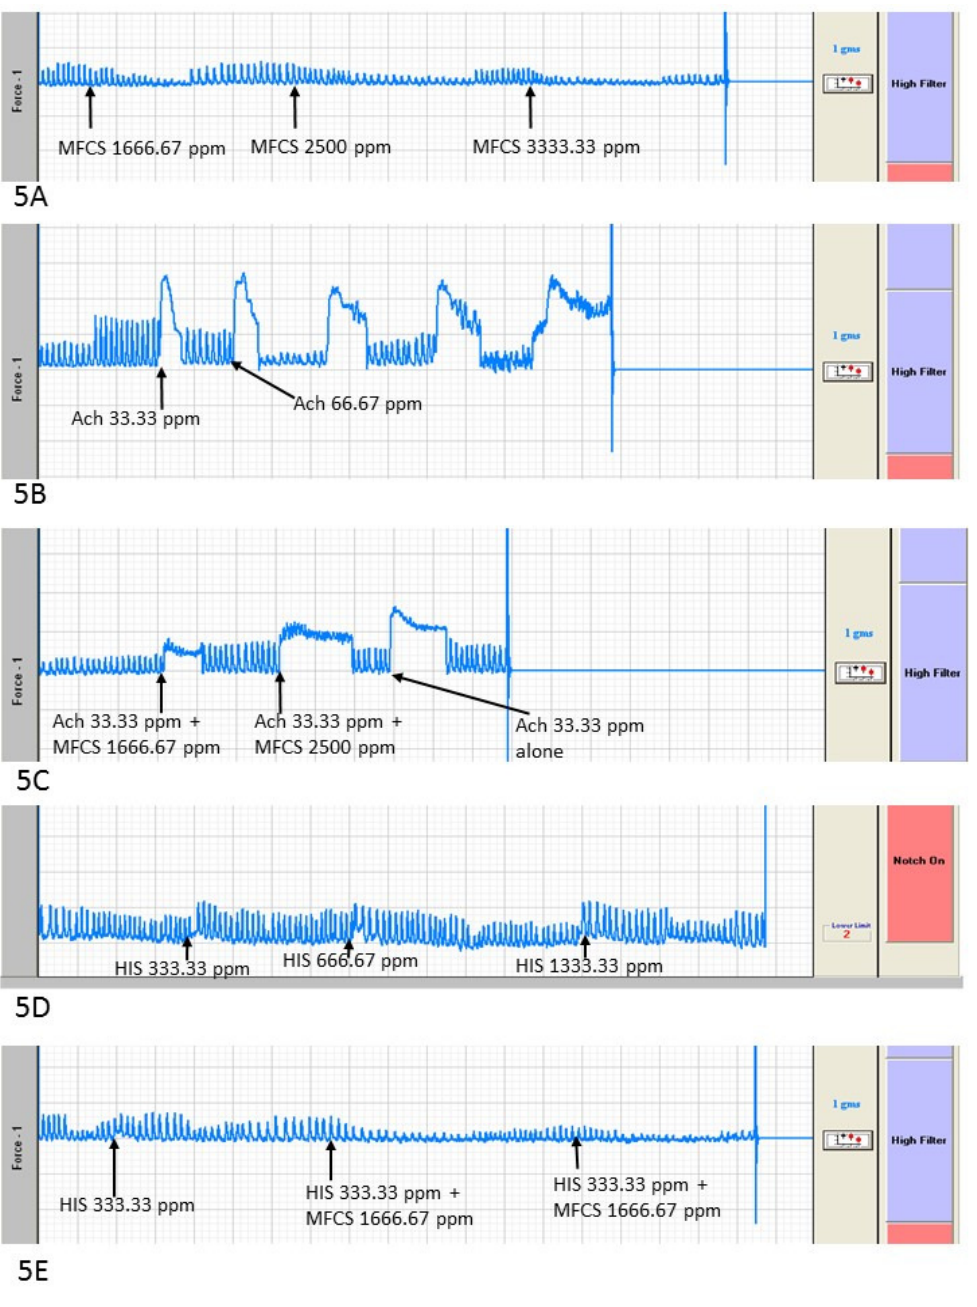
Figure 5. Effects of MFCS against isolated rabbit jejunum Legend: 5A = MFCS alone, 5B = acetylcholine (Ach) alone, 5C = MFCS and acetylcholine (Ach), 5D = histamine (HIS) alone, 5E = MFCS and histamine (HIS), MFCS = methanol fraction of Callichilia